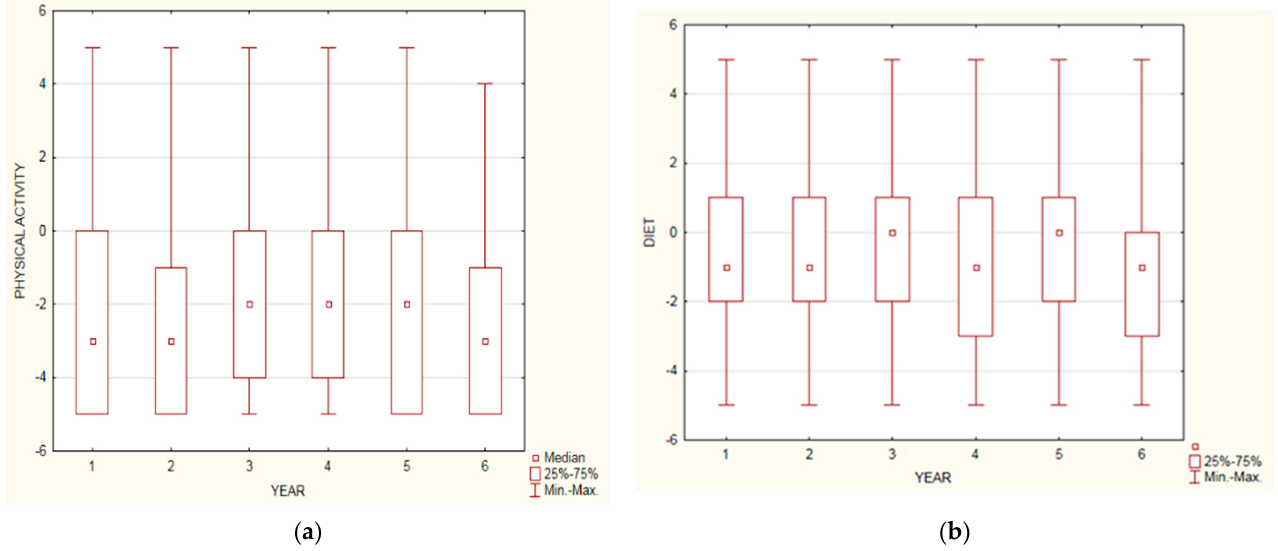
Figure 3. Results of self-opinion question depending on year of study on physical activity ( a ) and dietary habits ( b ): x—year of study, y—chosen answer (scale − 5, 0, +5).